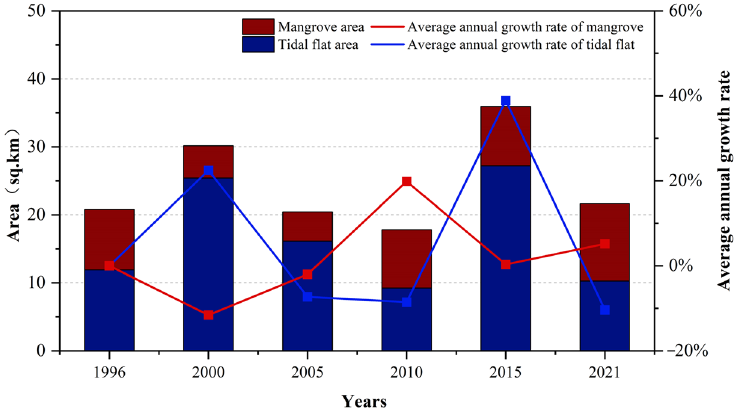
Figure 21. Map of land stock and annual growth rate in Pearl bay region from 1996 to 2021.